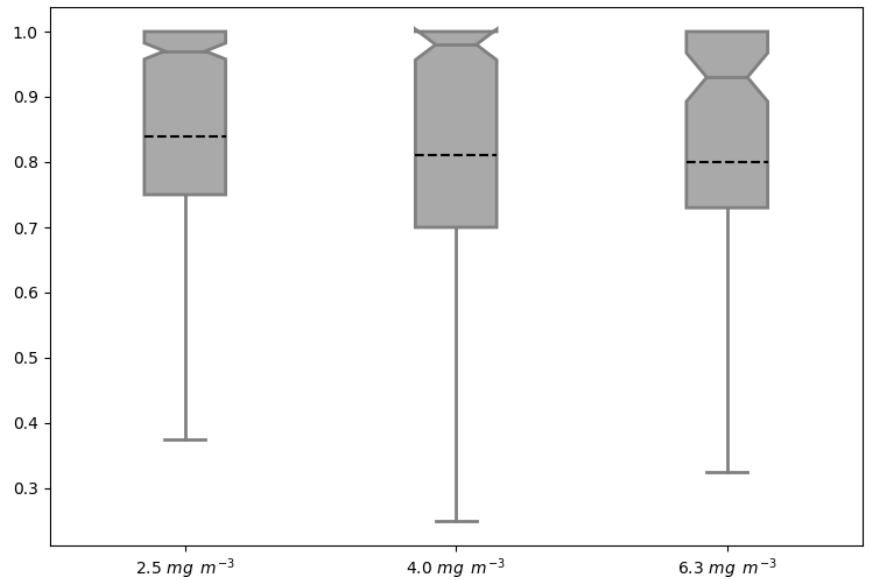
Figure 10. Box-and-whisker plots of the paired object property intersection-over-area ]ratio computed by dividing the spatially collocated area between the paired objects by the largest of either the AMM7v11 or L4 observed object areas (to keep the ratio to be bounded by 0 and 1). Three object thresholds are shown: 2.5, 4.0 and 6.3mgm − 3 . Smoothing radii of 5, 5 and 3 grid lengths were applied for the three thresholds, respectively. The sample sizes for each threshold were 1004, 401 and 130 paired objects,